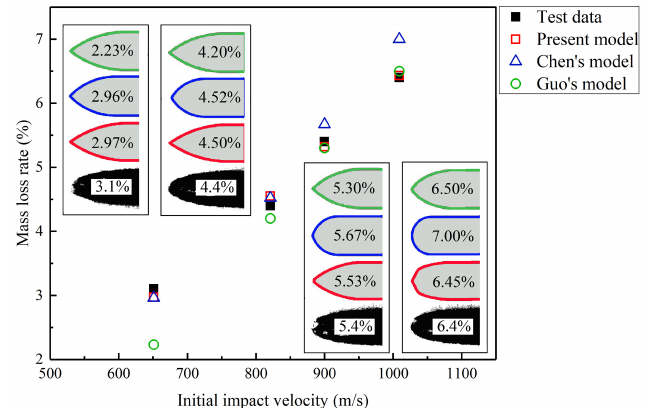
Figure 10. Relationship between impact velocity and mass loss rate. The proposed model agreed well with the experimental data and the residual projectile with different color contour lines represents the predictions by different